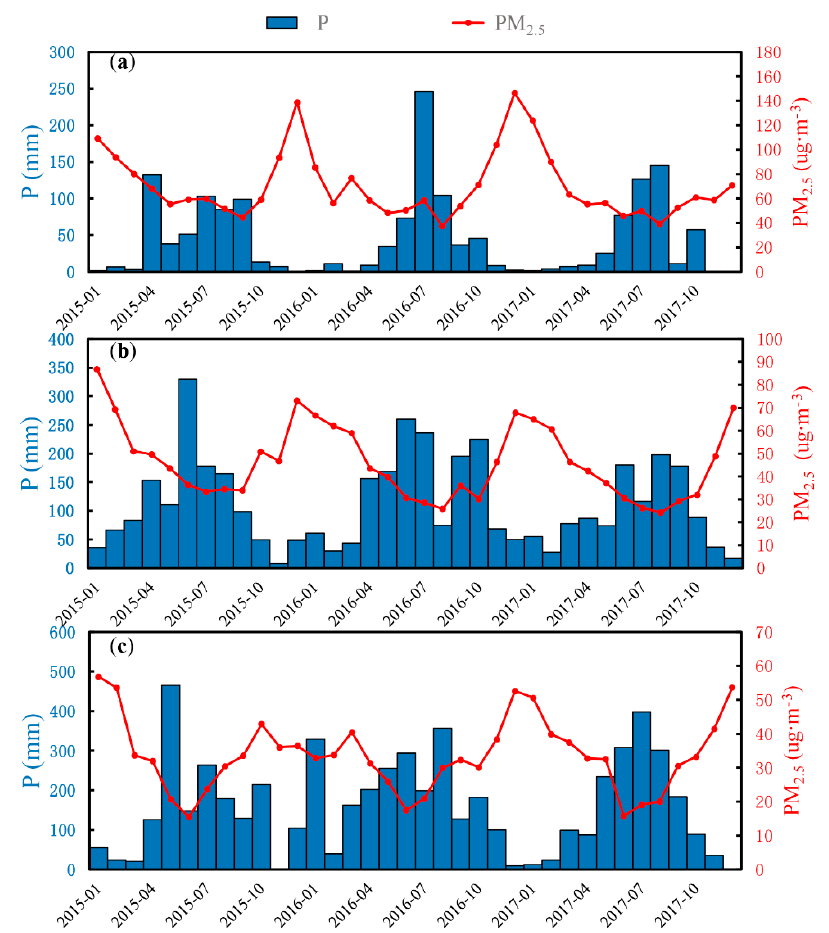
Figure 2. The monthly variations of precipitation and PM 2.5 mass concentration in the three research areas of ( a ) BTH, ( b ) YRD, and ( c ) PRD.